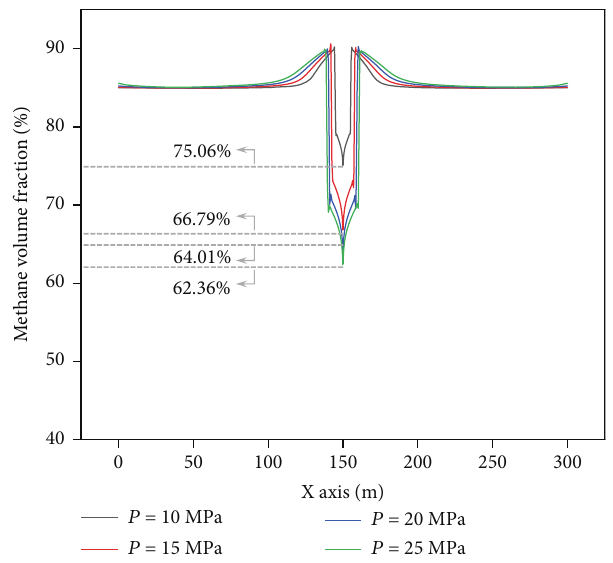
under di ff erent injection pressures. CH 4